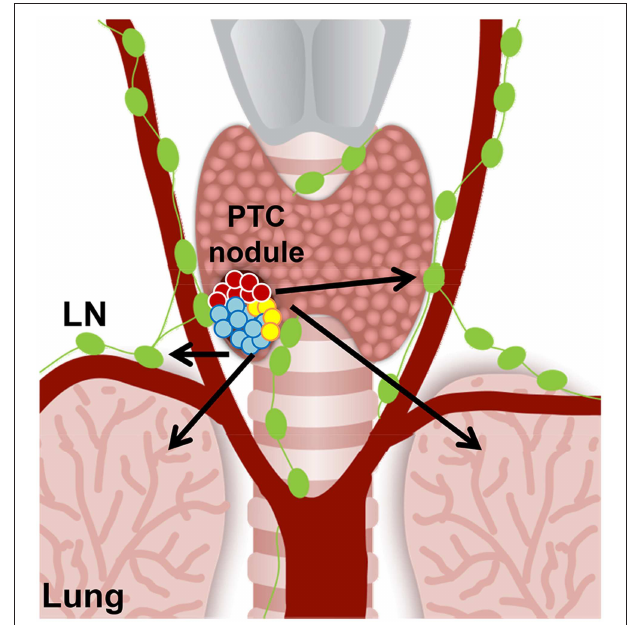
FIGURE 2 | Hypothetical cell composition of a BRAF WT / V600E papillary thyroid carcinoma (PTC) nodule. BRAF WT / V600E positive malignant thyroid nodule with heterogeneous tumor cell clusters that might have the potential for metastasis (arrows) to the neck lymph nodes (LN) and lungs/pleura. Red circles: diploid PTC cells; aqua and yellow circles: PTC cells with aneuploidy.